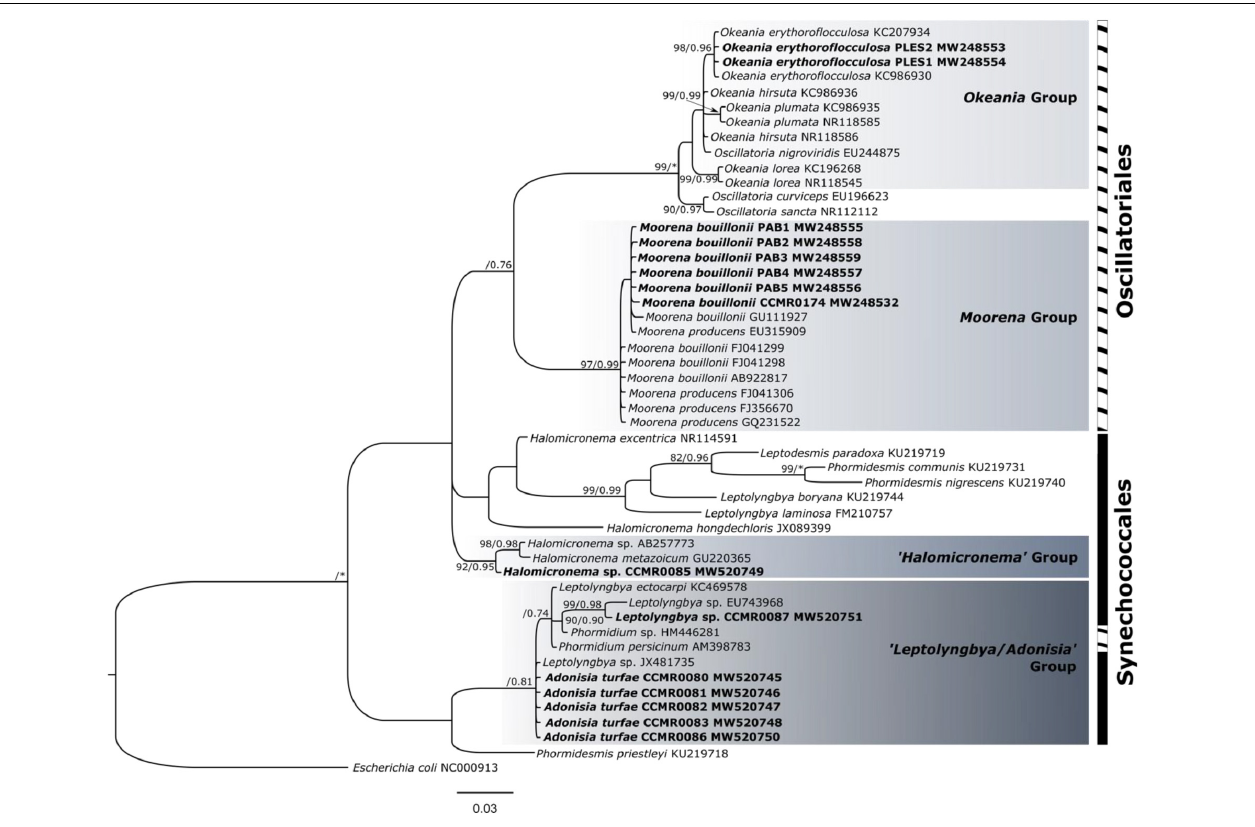
FIGURE 3 | Bayesian tree of the 16s rDNA genomic region of cyanobacteria from Abrolhos Bank (ntax = 49). The inference was constructed with K2P + G as a substitution rate model. Only support values > 70% are indicated. Maximum likelihood bootstrap values are on the left, and Bayesian posterior probabilities are on the right. Asterisks indicate 100% support. Sequences obtained in this study are indicated in bold. Scale bar = 0.03 substitutions per nucleotide position.